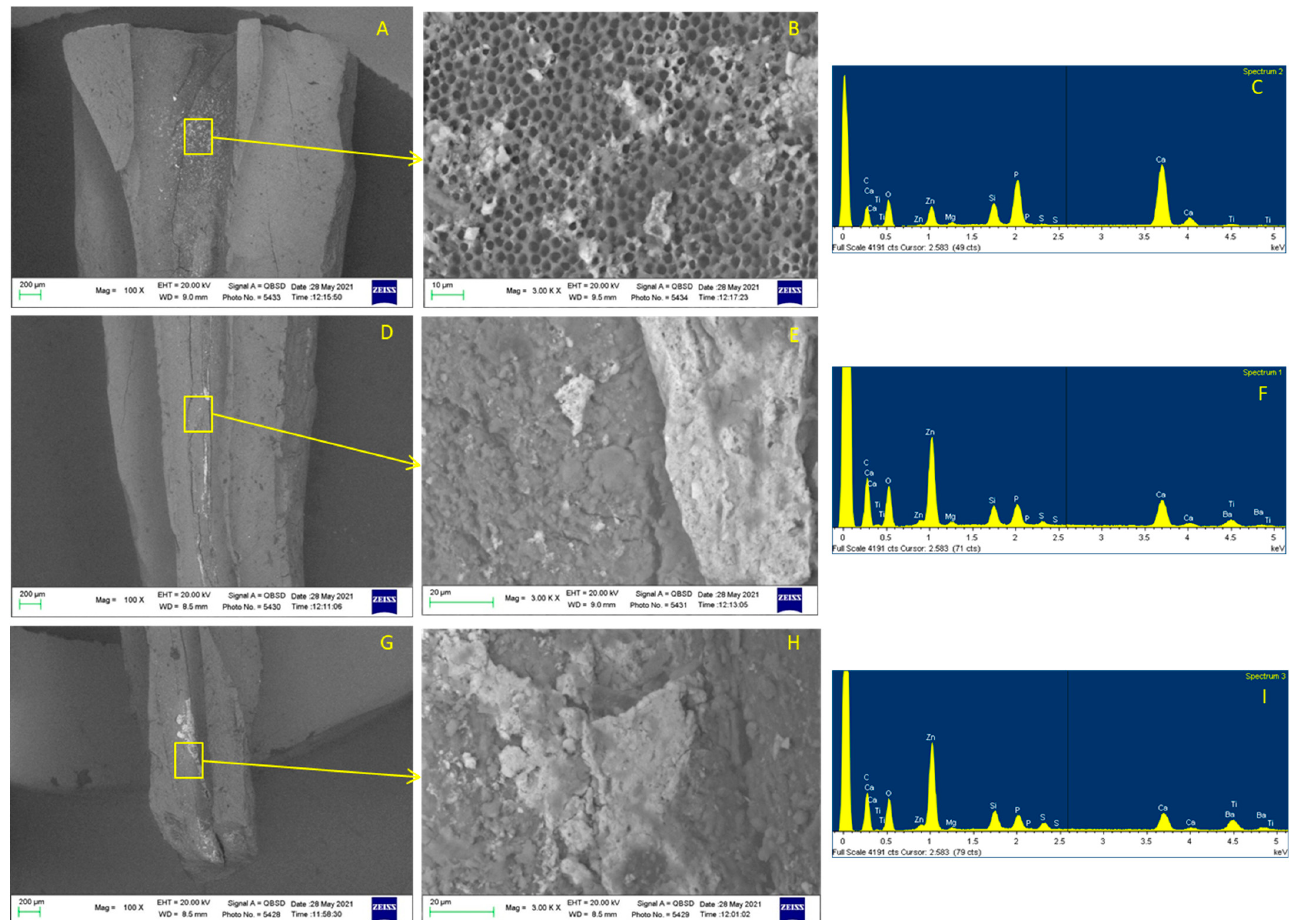
Figure 6. Root canal obturated with GF technique, sectioned, and examined with ESEM/EDX. Coronal third examination at 100 × ( A ) revealed a few electron-dense granules on the dentinal surface. Dentine surface at 3000 × ( B ) was characterized by open dentinal tubules and partially covered by the electron-dense remnants. EDX microanalysis ( C ) showed the presence of tracer elements attributable gutta-percha (Zn). Middle third at 100 × ( D ) displayed a high presence of electron-dense remnants. At high magnification (3000 × ), ( E ) the remnants completely covered the dentinal structure, with no signs of tubules. Some remnants were detected in the apical portion at 100 × magnification ( G ). At high magnification (3000 × ), ( H ) the dentinal tubules were completely covered by remnants. EDX on the remnants revealed high presence of elements from Guttafusion, namely Zn, Ba and Ti, and Si ( F , I ).